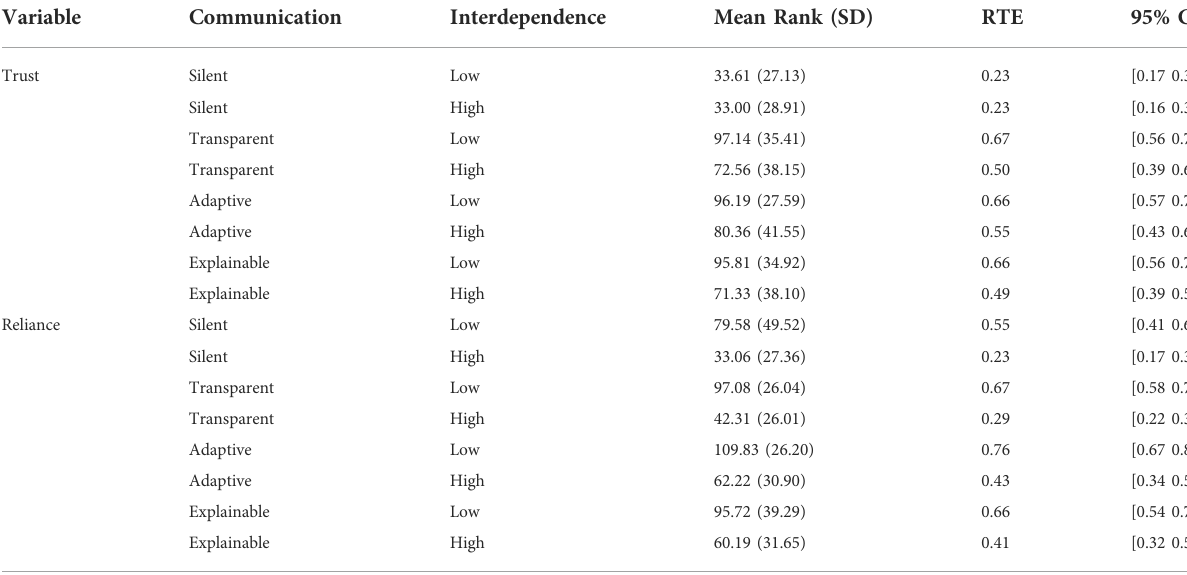
TABLE 3 Descriptive statistics for the dependent variables trust and reliance. Values correspond to the data points of the plots in Figures 2A,B. Variable